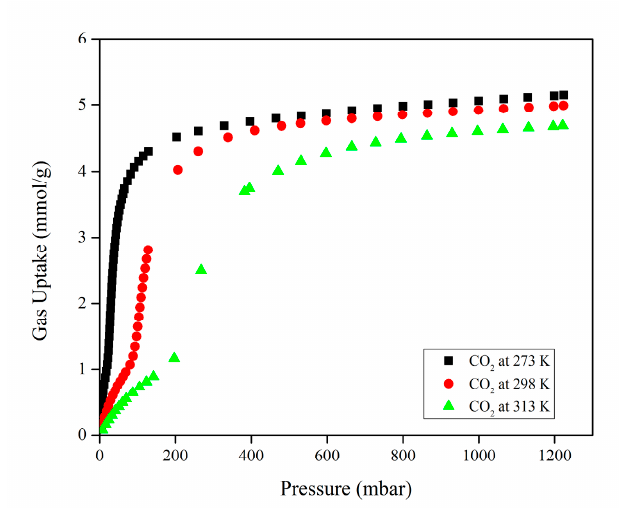
Figure 6. Experimental CO 2 single-component adsorption isotherms of Mg-gallate at 273, 298 and 313 K.